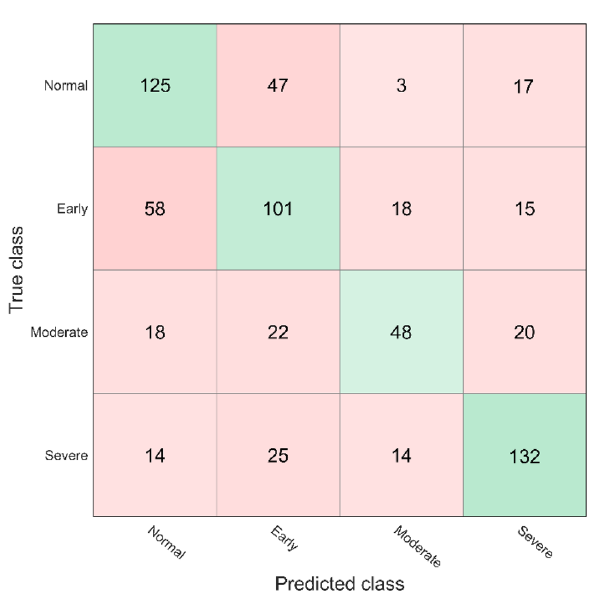
Figure 6. The predicted visual field damage from corneal parameters versus the true visual field damage of eyes at different visual field severity